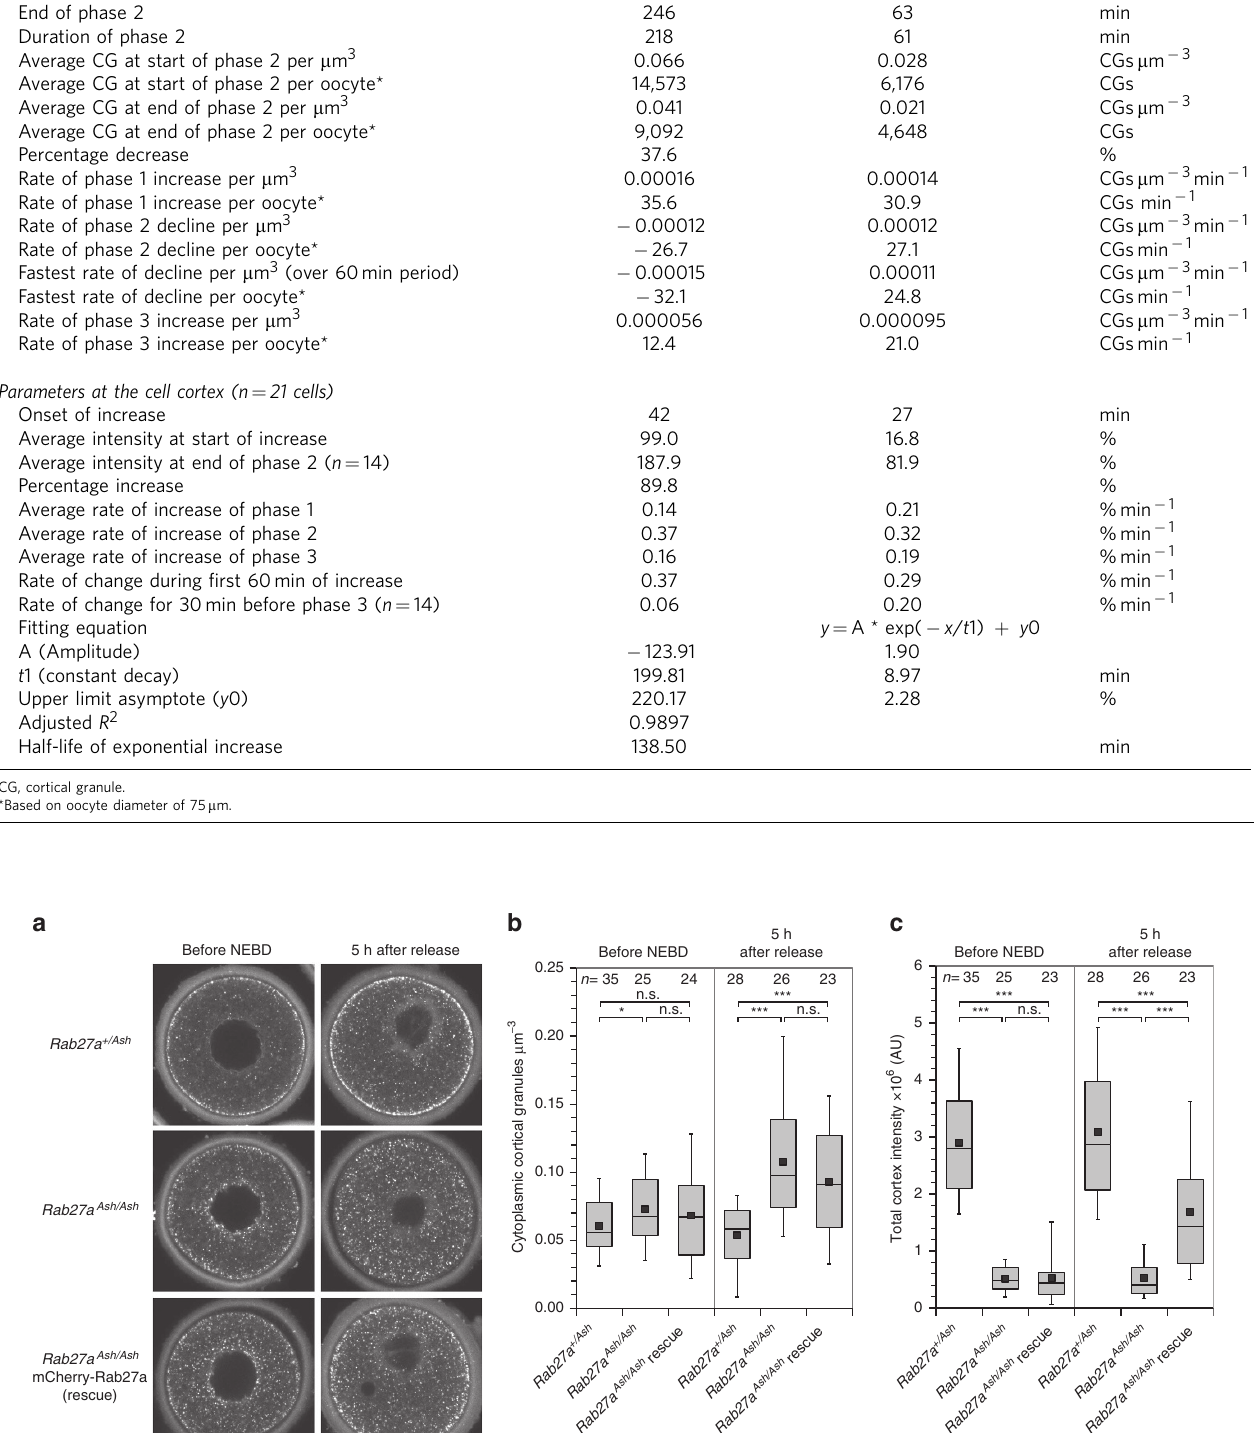
Table 1 | Parameters of cortical granule translocation in mouse oocytes. Parameters in cell centre (n ¼ 20 cells)